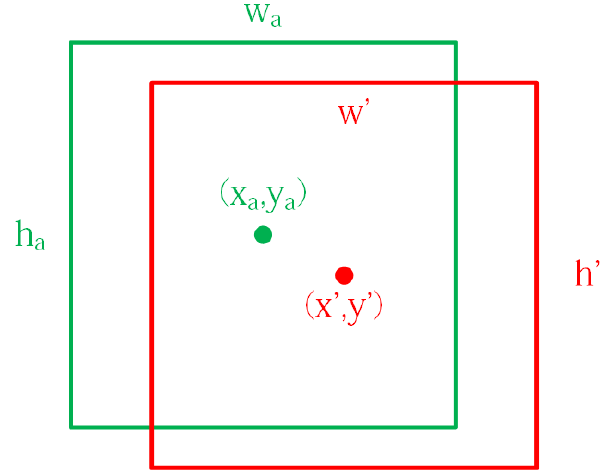
Figure 6. The red box represents the Ground Truth, the green box represents the positive sample. The (x,y) are the center coordinates of the box. The term w stands for width and h stands for height. Positive samples marked with angle a are the Ground Truth marked with angle ‘.